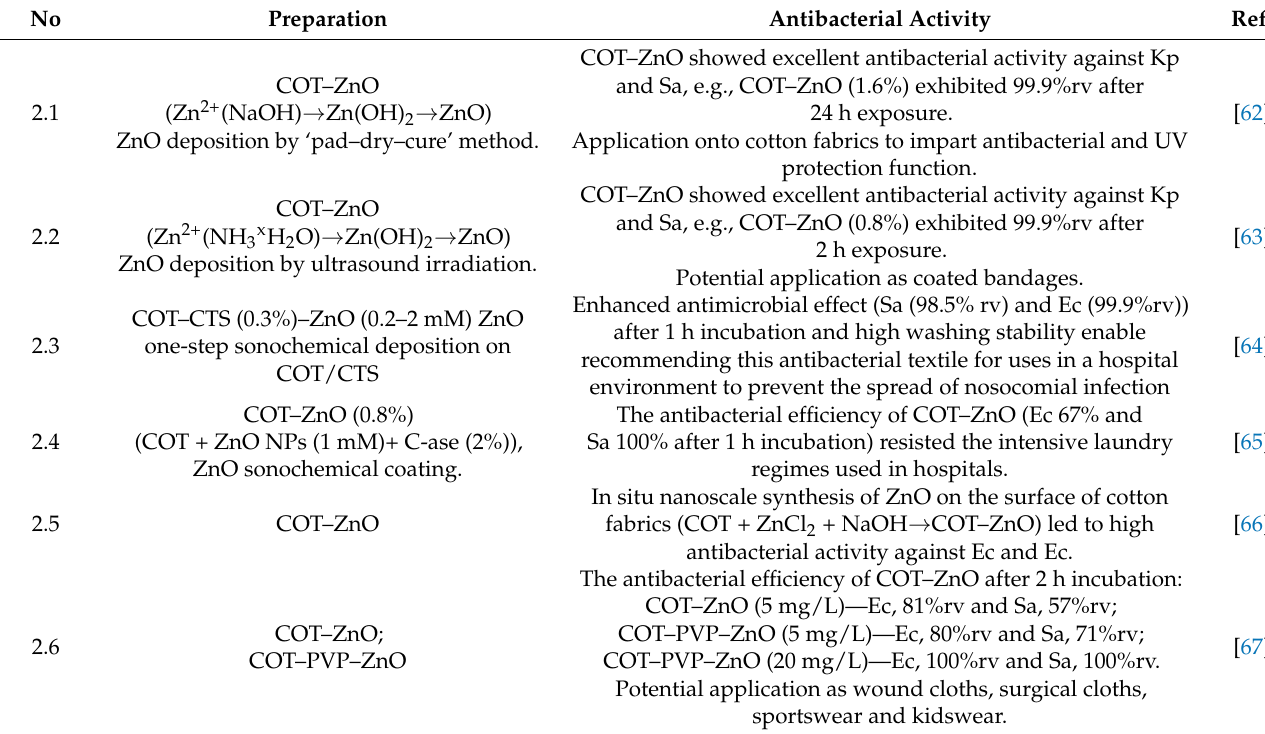
Table 1. Representative composite cotton/zinc